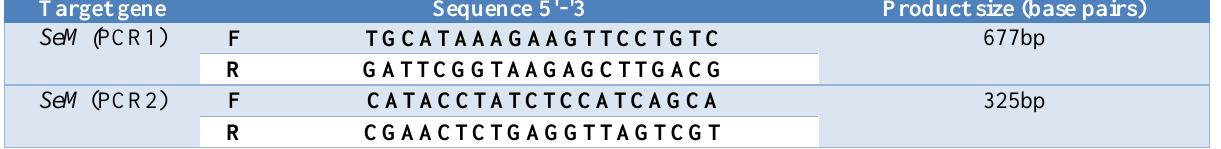
Table, 1: Oligonucleotide primers used in the PCR and PCR product size. Target